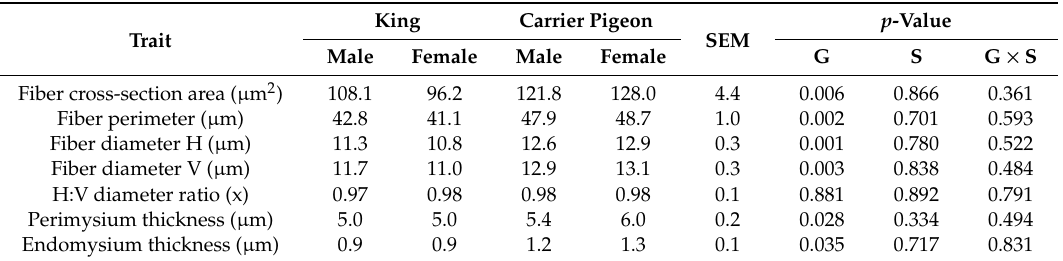
Table 6. Microstructure of the pectoralis major muscle in three-year-old pigeons of di ff erent genotypes.